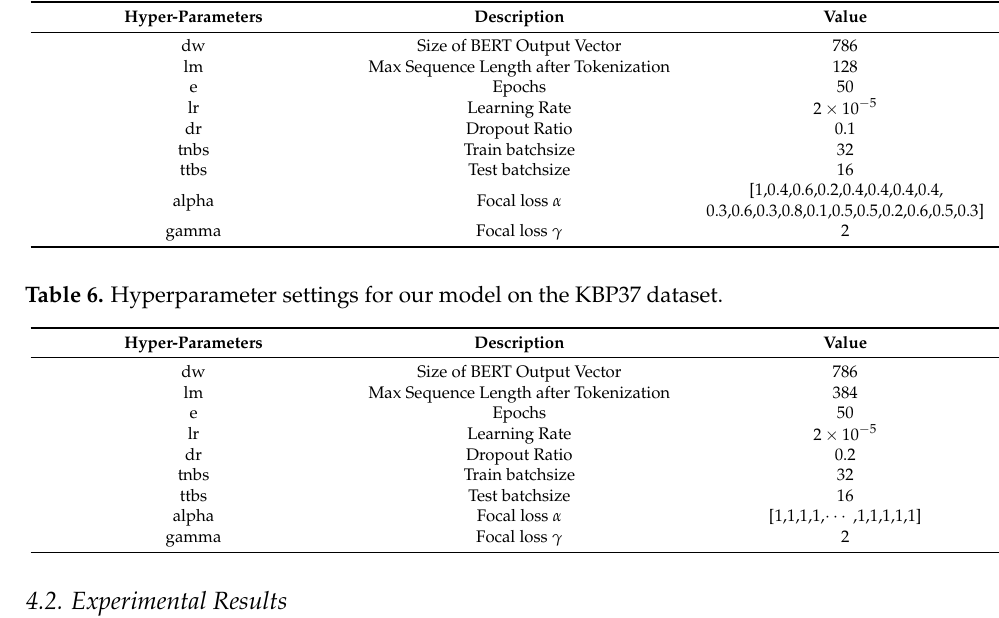
Table 5. Hyperparameter settings for our model on the SemEval-2010 Task 8 dataset.